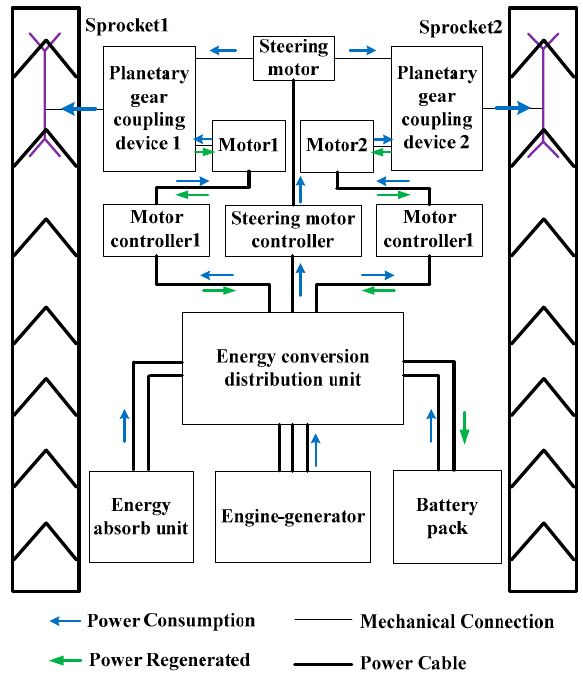
Figure 2. Steering coupling drive system configuration and power flow.